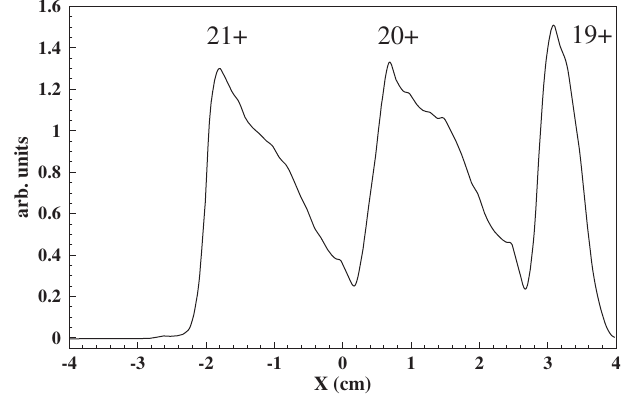
FIG. 5. Measured bismuth beam profiles at the slits.